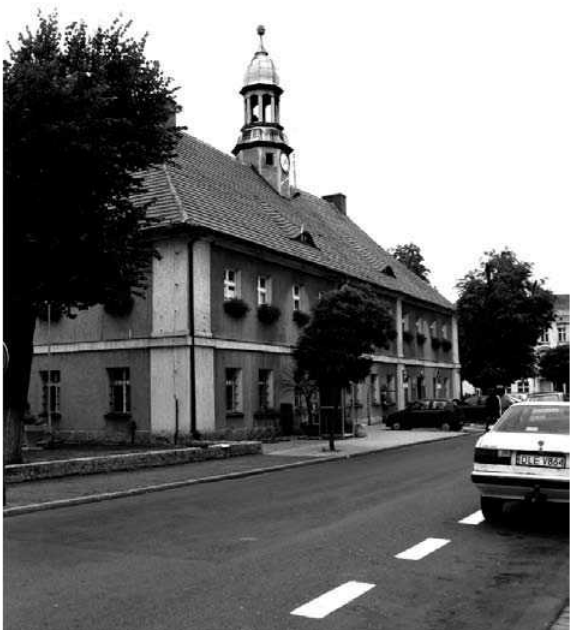
Fig. 3. Town hall on market square in Prochowice